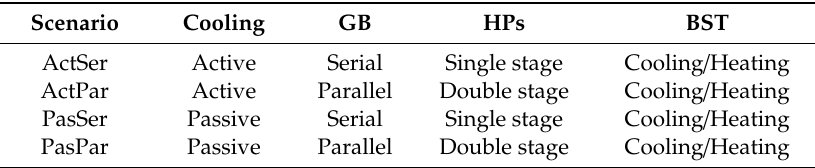
Table 1. The proposed scenarios.